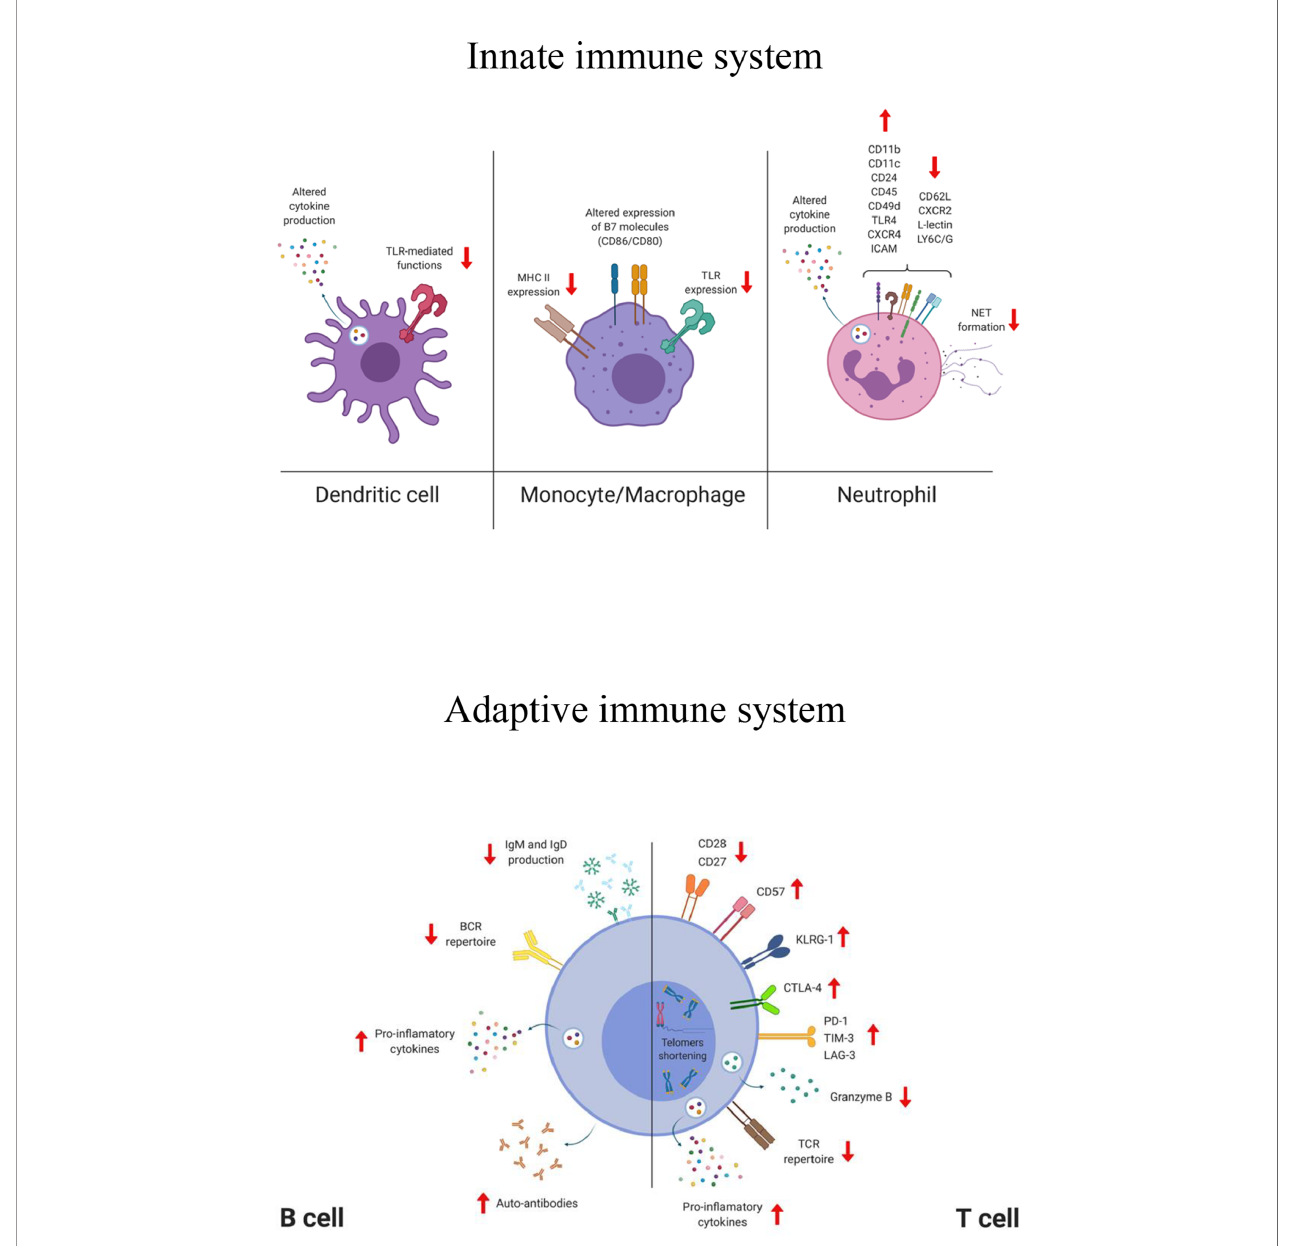
FIGURE 1 | Simpli fi ed representation of the phenotypical and functional changes affecting cells of the innate and adaptive compartment during aging. TLR, toll like receptor; MHC, major histocompatibility complex; CXCR, C-X-C chemokine receptor; ICAM, intercellular adhesion molecule; LY6C/G, lymphocyte antigen 6 complex (locus C/G); NET, neutrophil extracellular trap; BCR, B cell receptor; TCR, T cell receptor; KLRG-1, killer-cell lectin like receptor G1; CTLA-4, cytotoxic T-lymphocyte antigen 4; PD-1, programmed cell death protein 1; TIM-3, T cell immunoglobulin and mucin domain-containing protein 3; LAG-3, lymphocyte-activation gene 3. The fi gure was created with